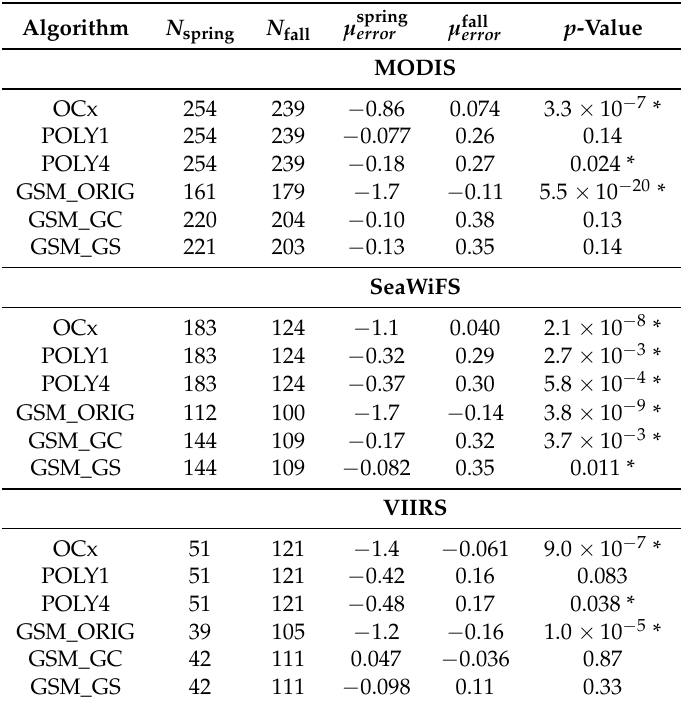
Table A3. Results of the t -test performed on µ error of seasonal subsets in the NWA to test for statistically significant differences in mean error between spring and fall. N = size of subset. * = statistically significant ( p -value < 0.05).